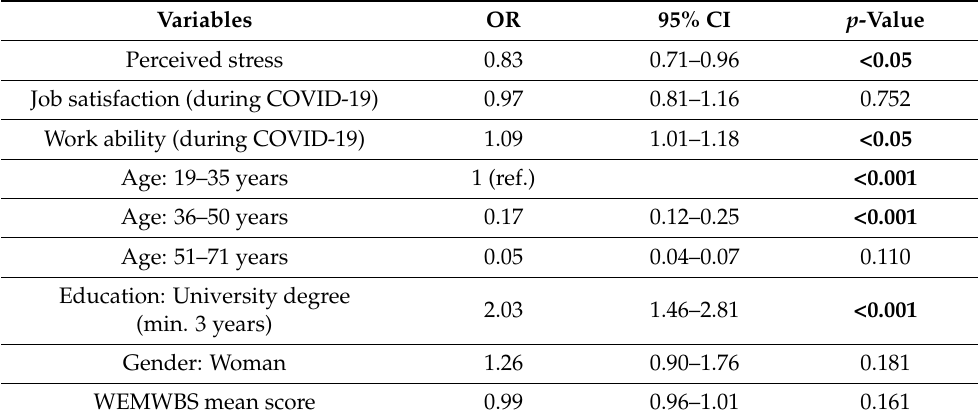
Table 6. Data of the binary logistic regression analysis conducted to predict whether the respondents have children under the age of 18 or not.